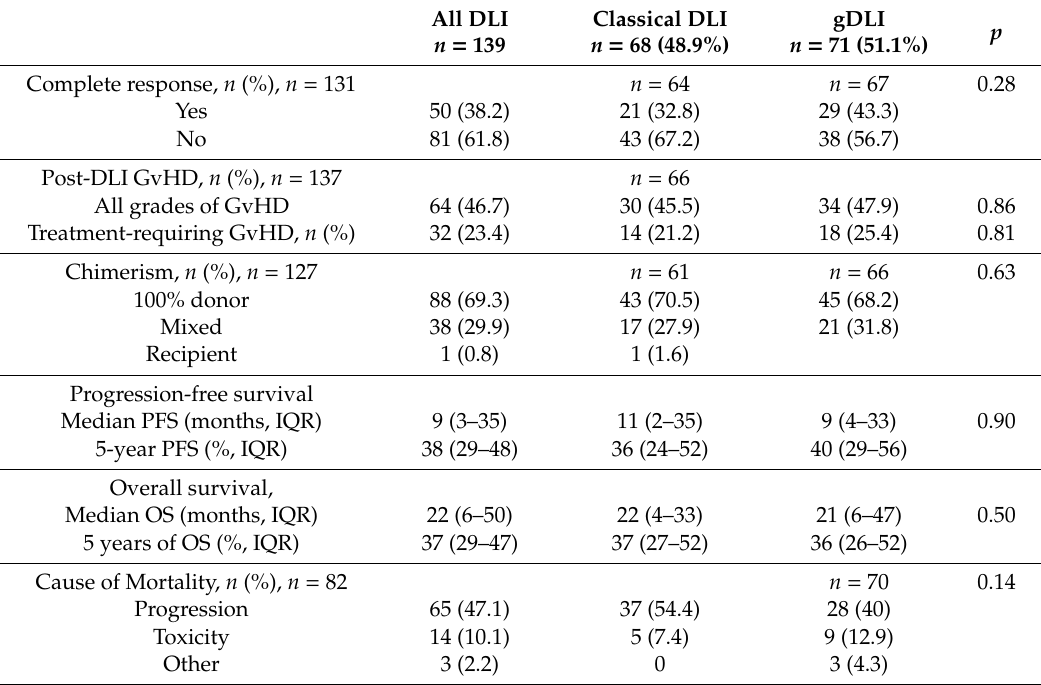
Table 3. Patient outcomes, n =